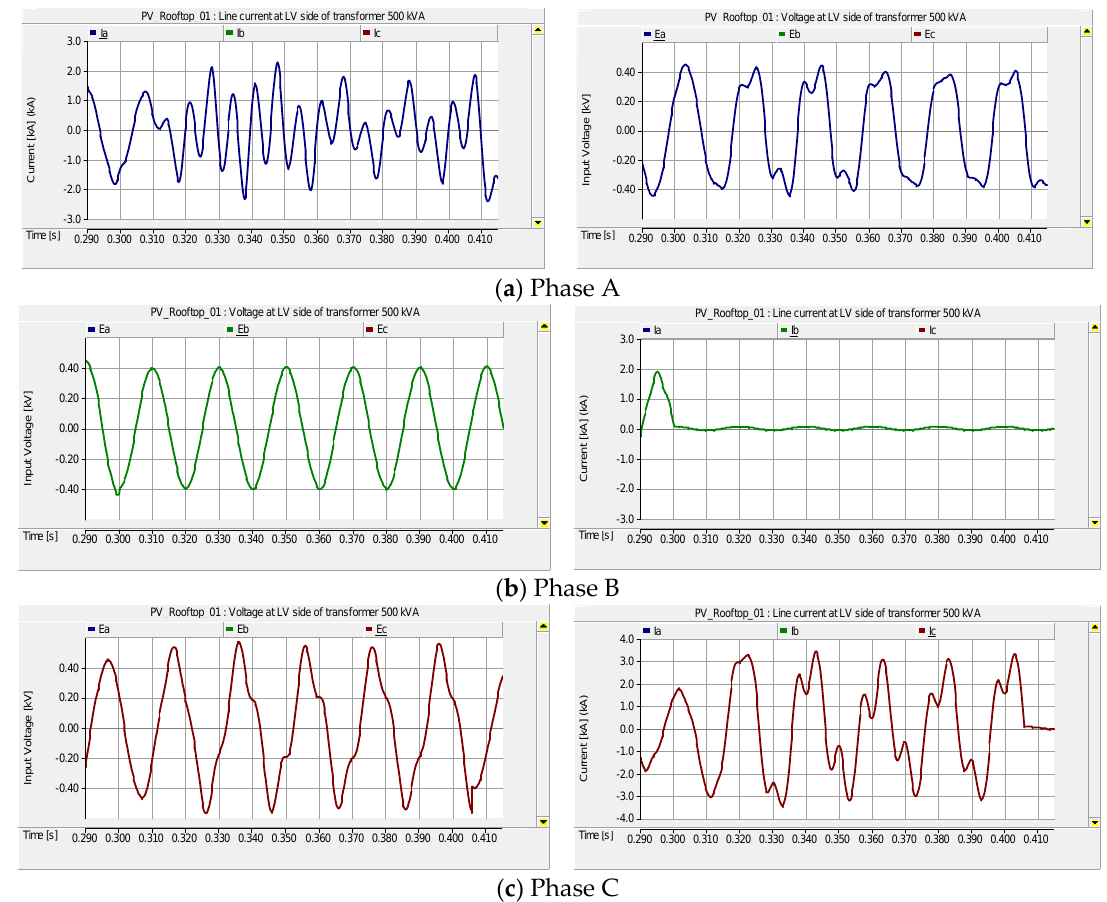
Figure 17. The voltage and current at the LV side (0.4 kV) transformer 500 kVA when the BRKB open circuit is at 0.3 s.